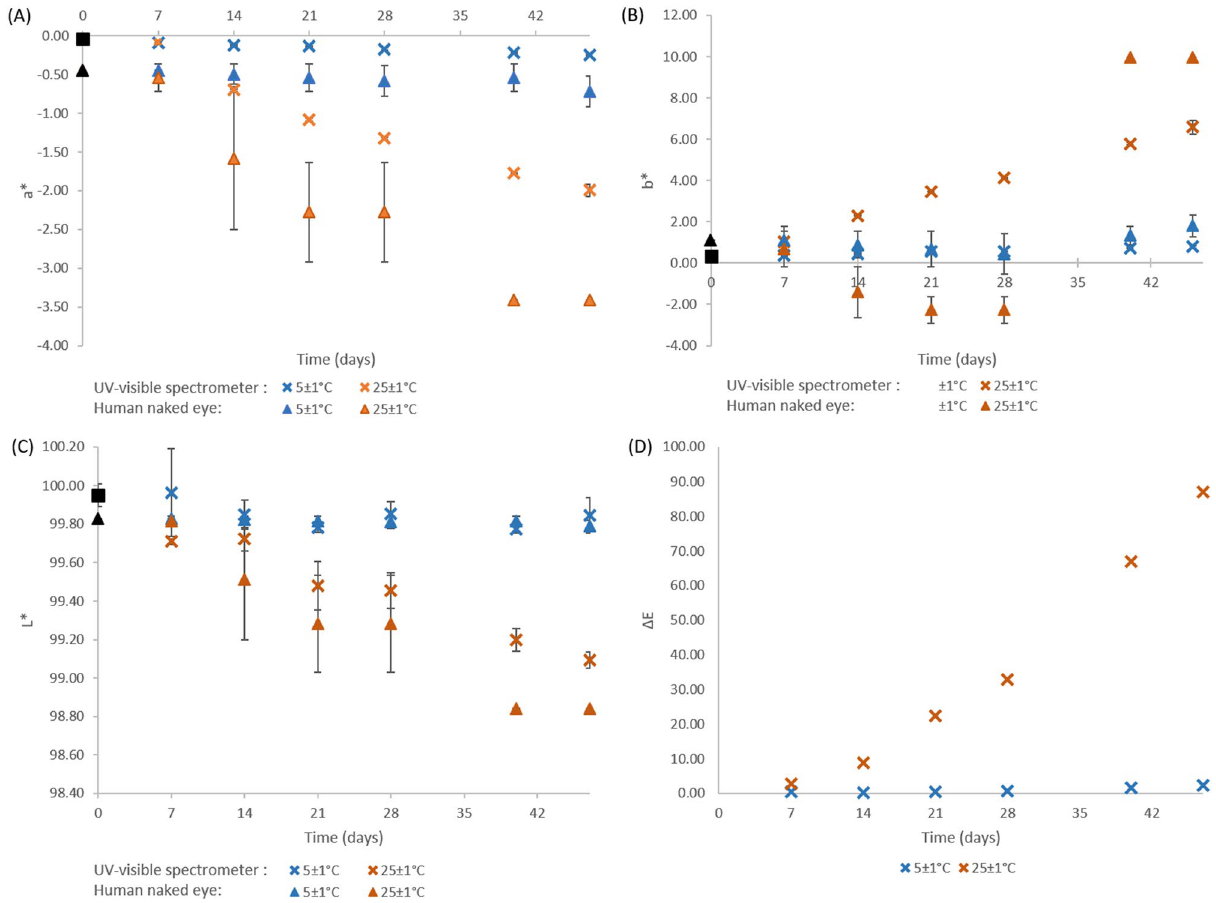
Figure 4. Colors parameters of parenteral nutrition solution observed by UV–Vis spectrometer or visual examination according to time and light exposition conditions: ( A ) a*, ( B ) b*, ( C ) L* and ( D ) ∆E (only for the spectrophotometric analysis). Results expressed as mean ± standard deviation, n = 3, except for ( D ) (difference of means, n = 1). Crosses: spectrophotometric data; triangles: human naked eye (visual examination)